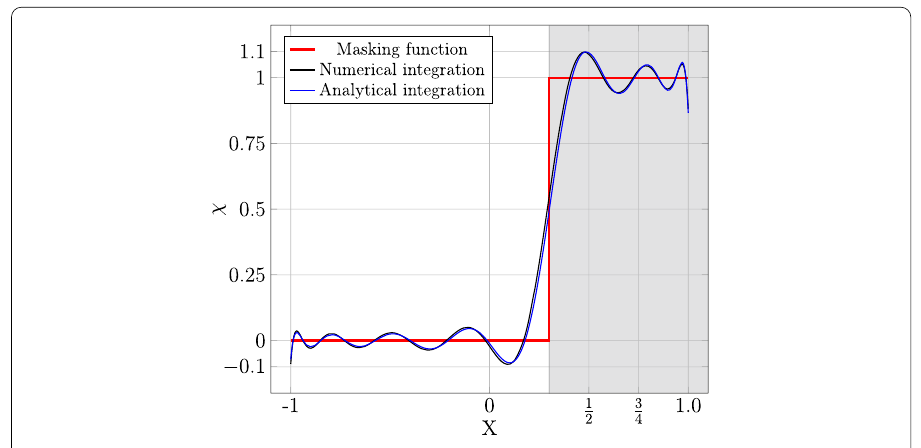
Fig. 2 Masking function χ (red) approximated in polynomial space with 16 terms. Comparison of the numerical integration with over-integration by a factor of three (black) and analytical integration